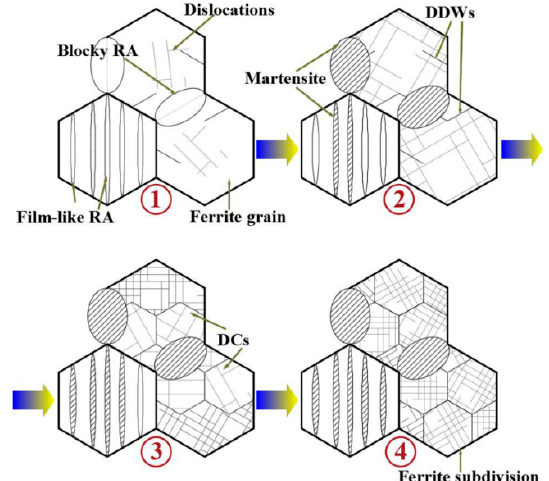
Figure 11. Schematic figure of the microstructure evolution during deformation of the tested steel.